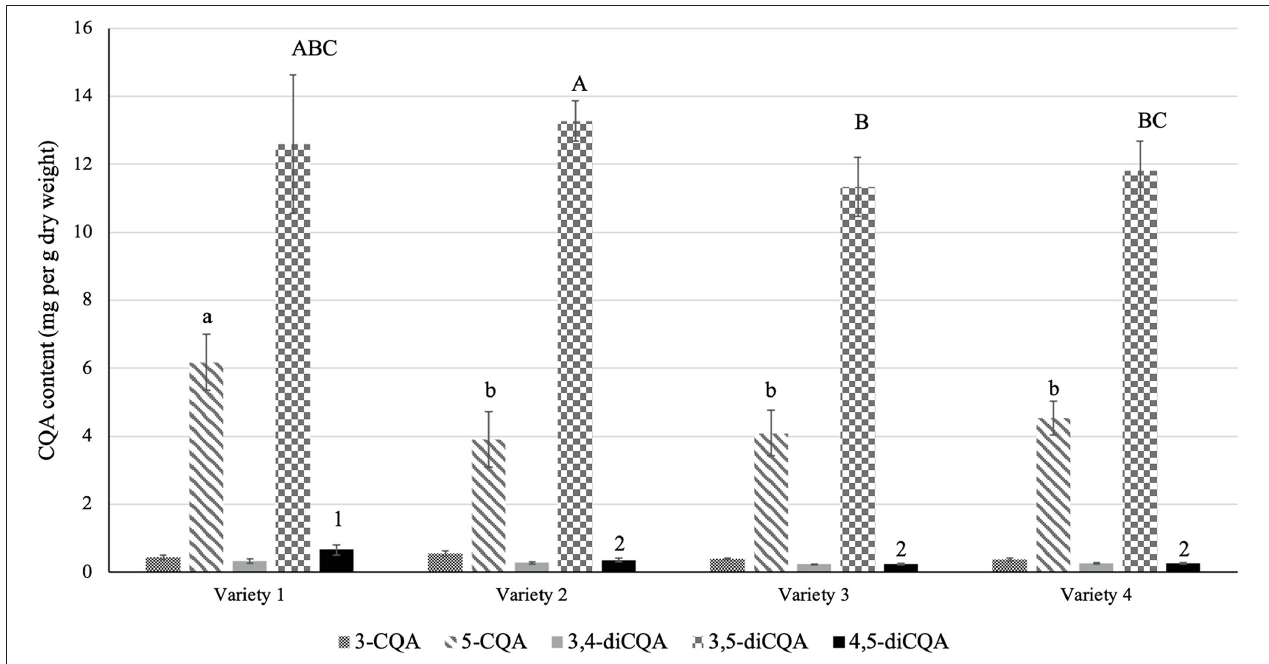
FIGURE 1 | CQA content of different sunflower sprout varieties. Seeds of four different varieties of sunflower sprout (1: Lungtop line, 2: Chiatai, 3: 3A, 4: Fourtid) were purchased and germinated. Sprouts were then extracted for CQA profiling. Error bars represent means ± standard deviations (SD), and three independent biological replicates were performed. For each CQA derivative, comparisons are made among varieties; bars with different letters or numbers differed significantly according to Duncan’s multiple range test ( P < 0.05). The content of 3-CQA and 3,4-diCQA did not vary significantly among the varieties according to Duncan’s multiple range test ( P >